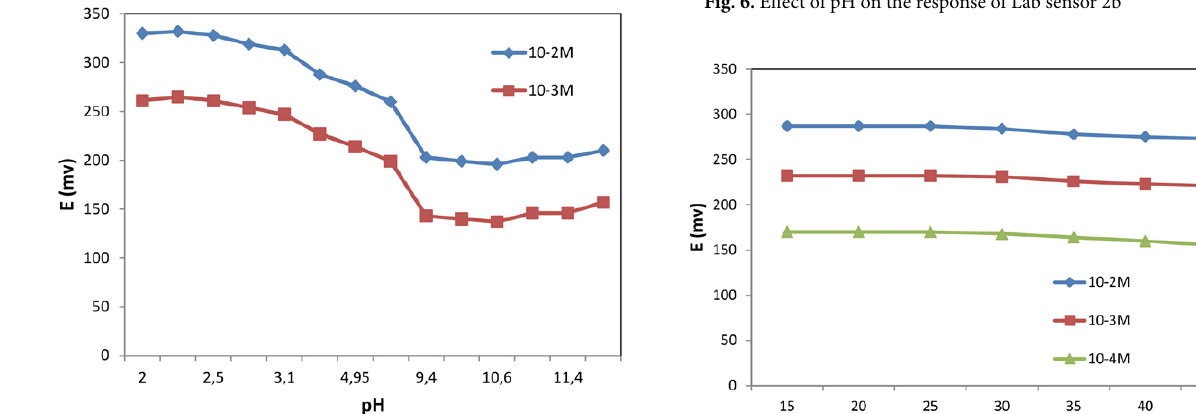
Fig. 6. Effect of pH on the response of Lab sensor 2b